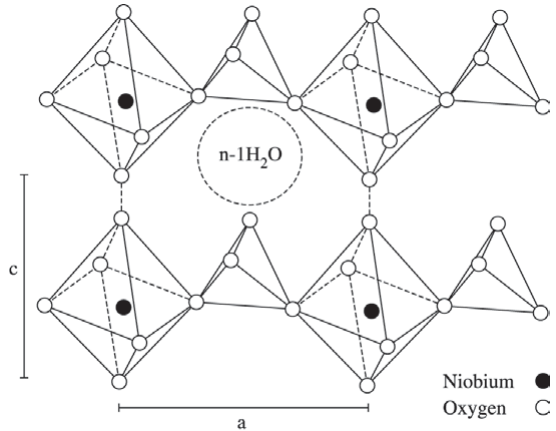
Figure 2. Fragment of NbOPO